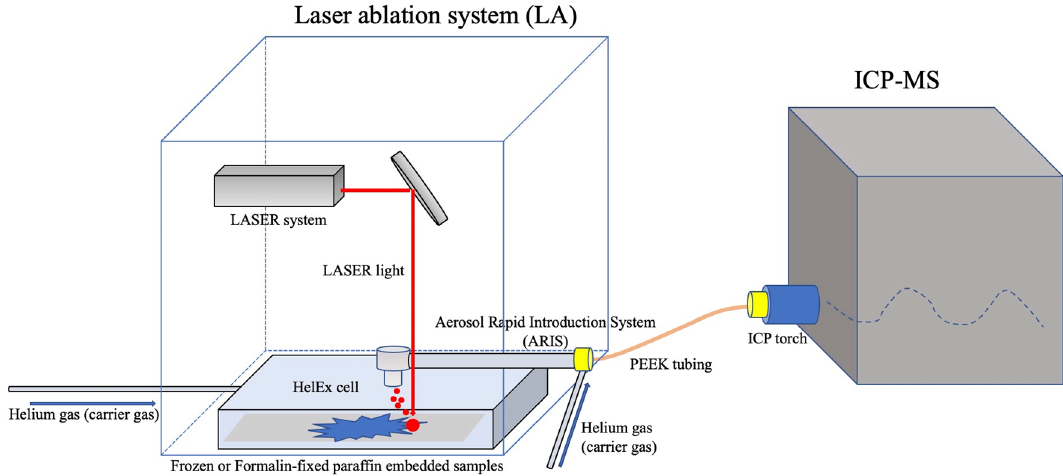
Figure 1. Representative LA-ICP-MS image. FFPE samples inserted into a HelEx cell box are ablated by the focused laser. The ablated samples are carried through the aerosol rapid introduction system (ARIS) to the